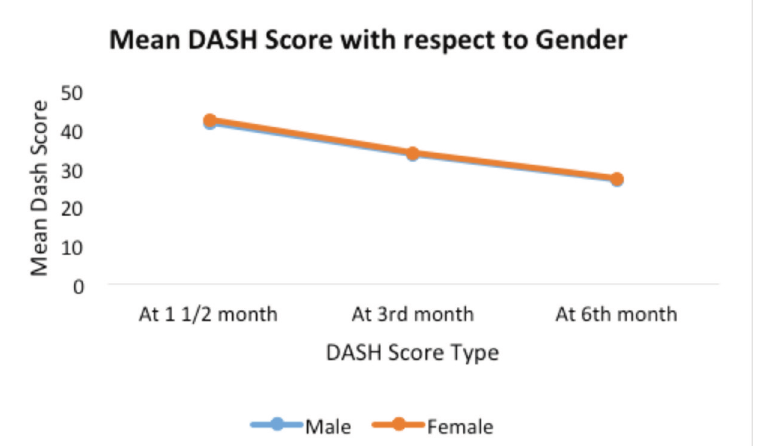
Mean DASH score vs Fig. 6: